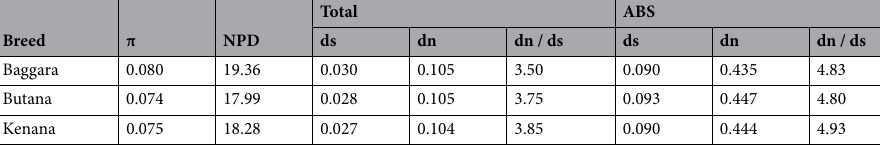
Table 3. Nucleotide diversity (π), mean number of pairwise differences (NPD) and mean number of non- synonymous (d n ) and synonymous (d s ) nucleotide substitutions per